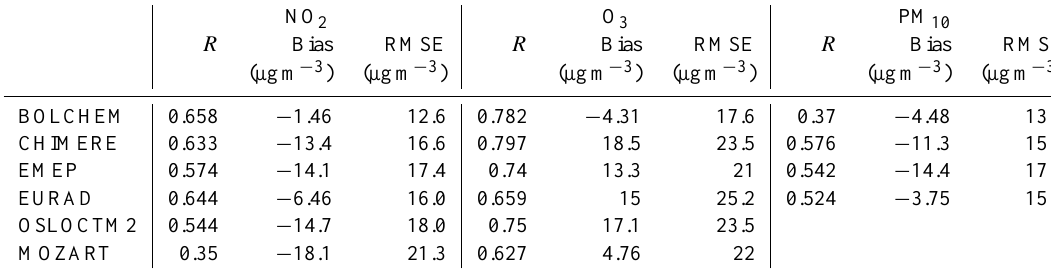
Table 4. Model performances at AIRBASE suburban stations computed over 10 yr on the basis of daily means. NO